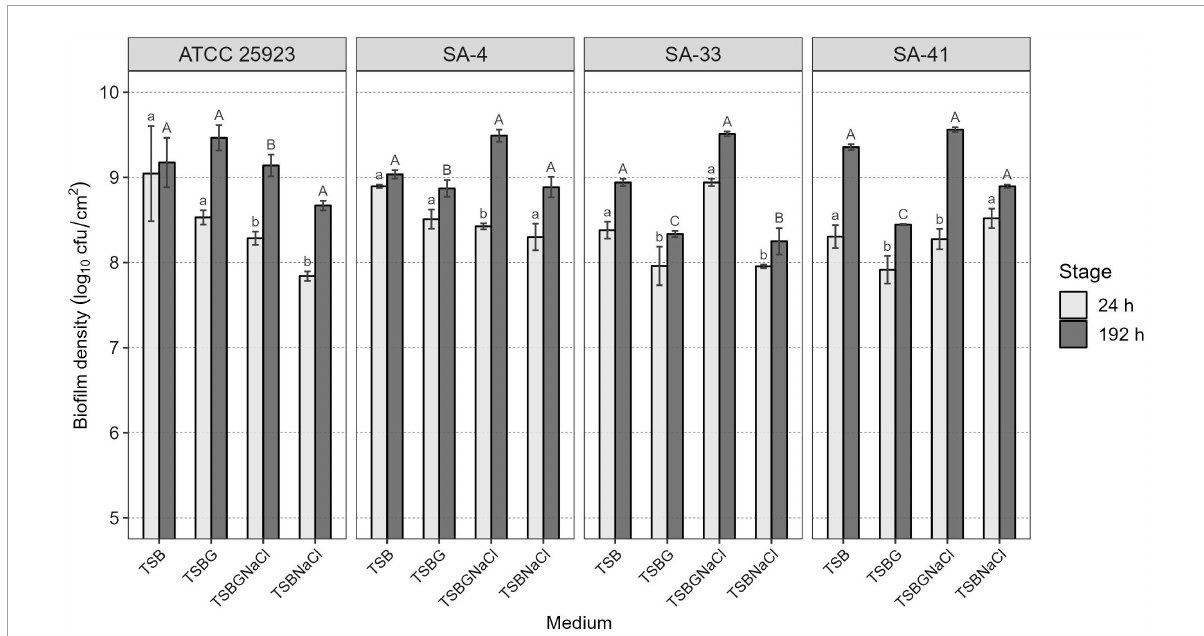
FIGURE1 Cell density of S. aureus biofilms developed in different enriched media at 24 and 192 h of maturity. Different lowercase letters indicate significant differences between S. aureus strains on the same growth medium at 24 h of development and uppercase letters at 192 h, according to the Tukey test ( p < 0.05). TSB, Tryptic soy broth; TSBG, TSB + 0.4% Glucose; TSBNaCl, TSB + 4% NaCl; TSBGNaCl, TSB + 0.4% Glucose + 4%